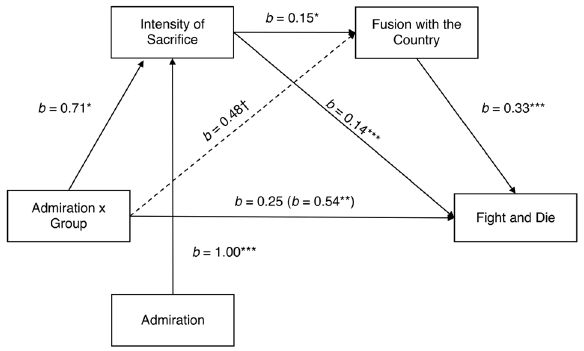
Fig. 4 Linear mediation model in Study 4 ( N = 253). In the ingroup conditions, level of admiration in fl uenced willingness to fi ght and die via 1) intensity of sacri fi ce alone, b = 0.24, 95% CI [0.10, 0.40], (2) identity fusion alone, b = 0.20, 95% CI [0.06, 0.36], and (3) intensity of sacri fi ces and fusion with country serially, b = 0.09, 95% CI [0.01, 0.20]. In the outgroup conditions, level of admiration in fl uenced willingness to fi ght and